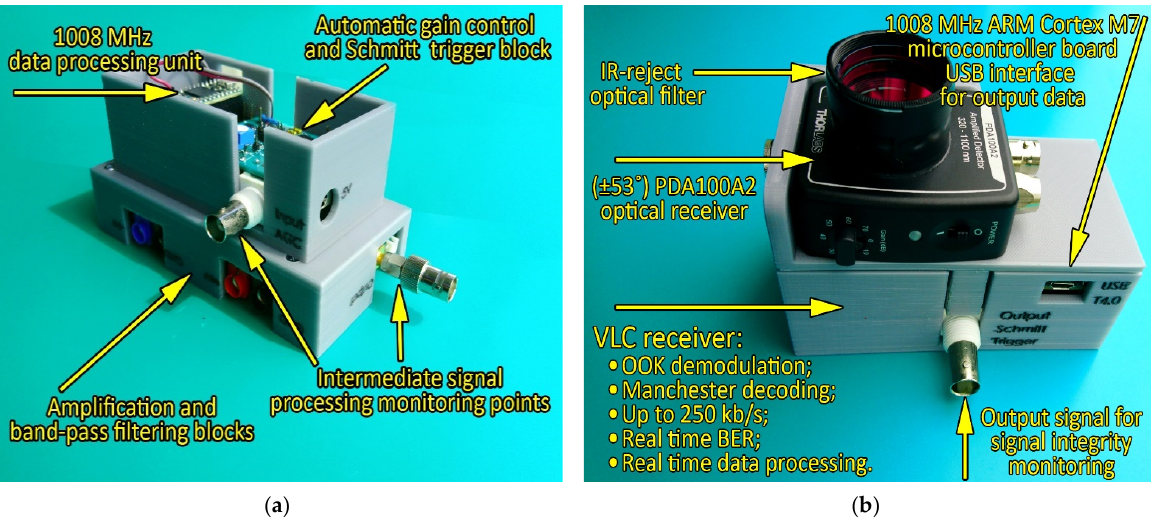
Figure 5. Visible light communications receiver prototype: ( a ) lateral view before integrating the optical receiver; ( b ) complete VLC receiver prototype.